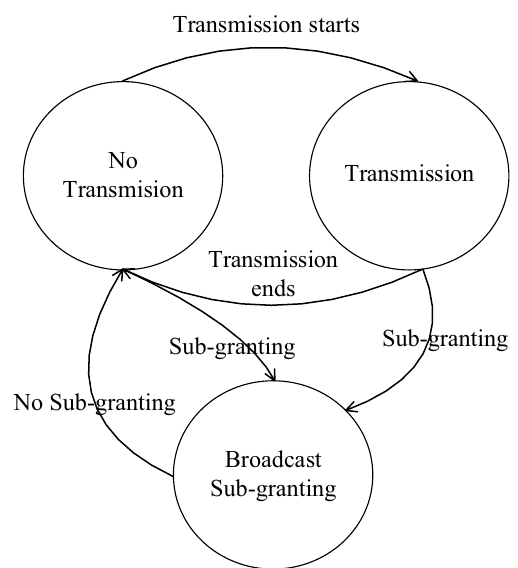
Fig. 4 State‑machine diagram of sub‑grant provider functionality